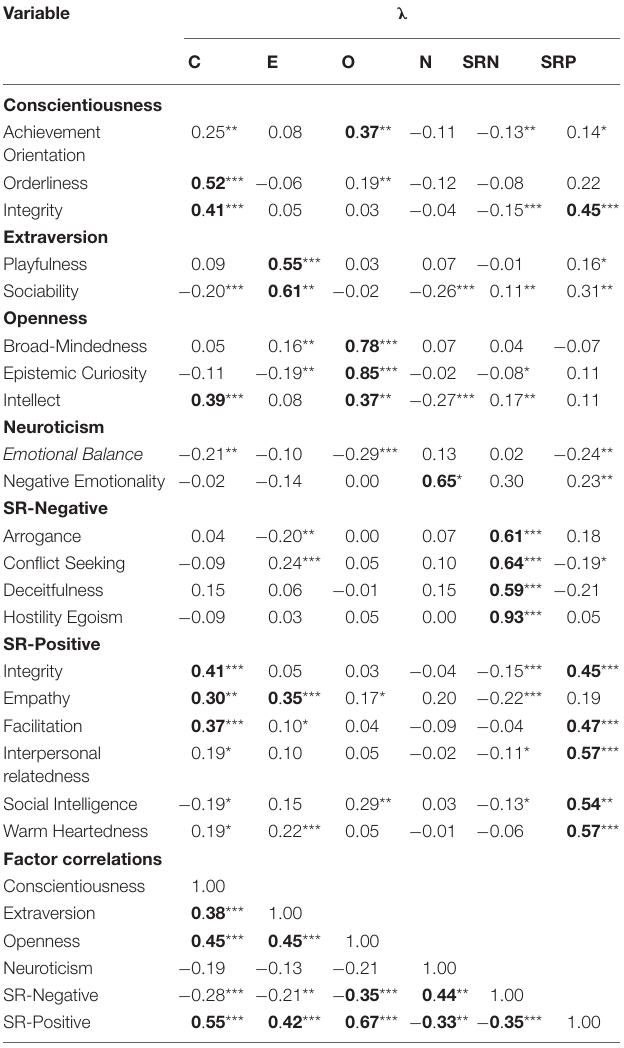
TABLE 5 | Standardized estimates of the SAPI-VE based on the ESEM